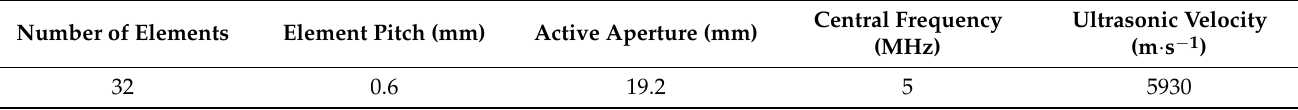
Figure 4. The testing specimen and defects in the simulation and experiment. Table 1. Array parameters in the simulation and